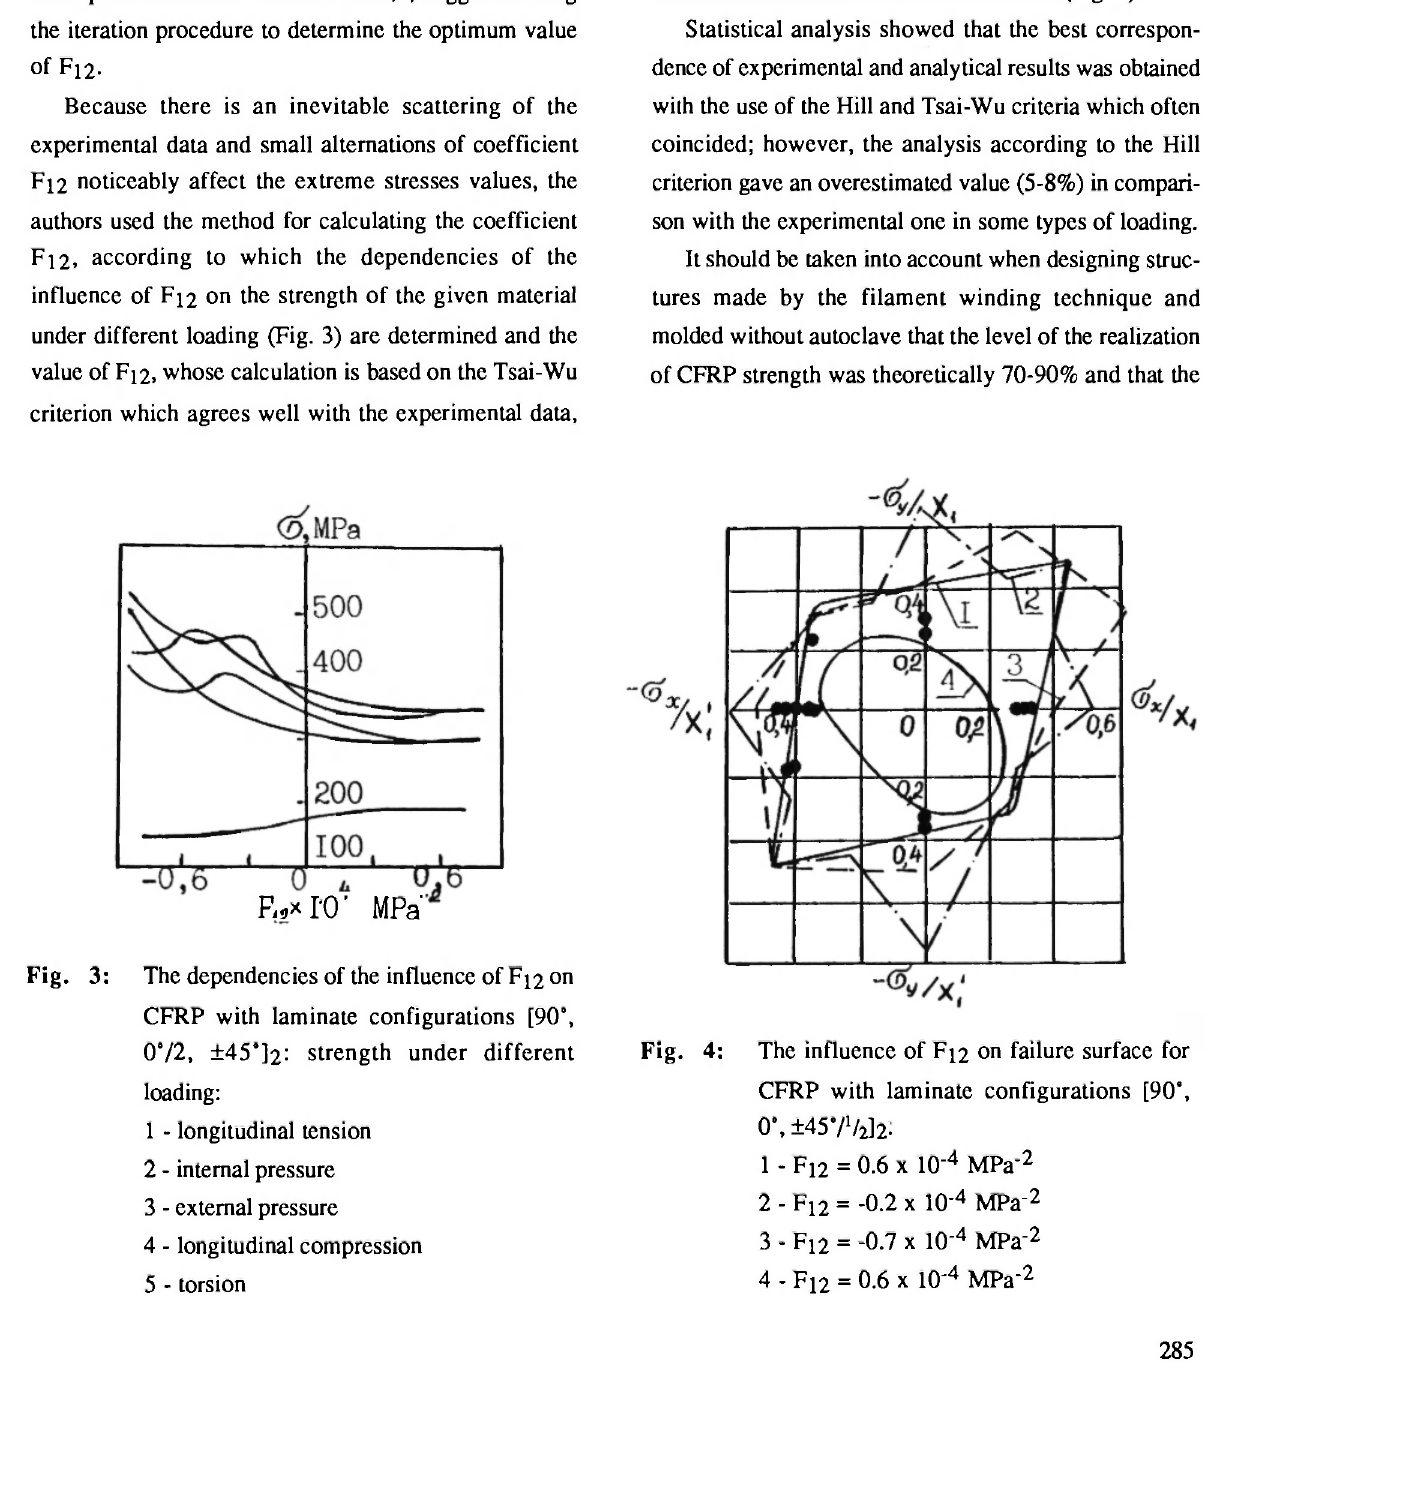
The influence of F12 on failure surface for CFRP with laminate configurations